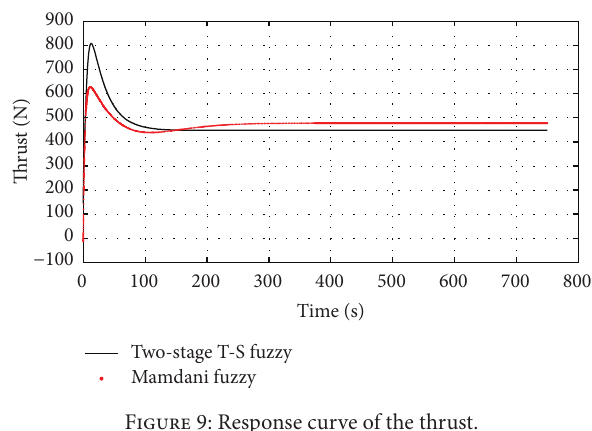
Figure 9: Response curve of the thrust.